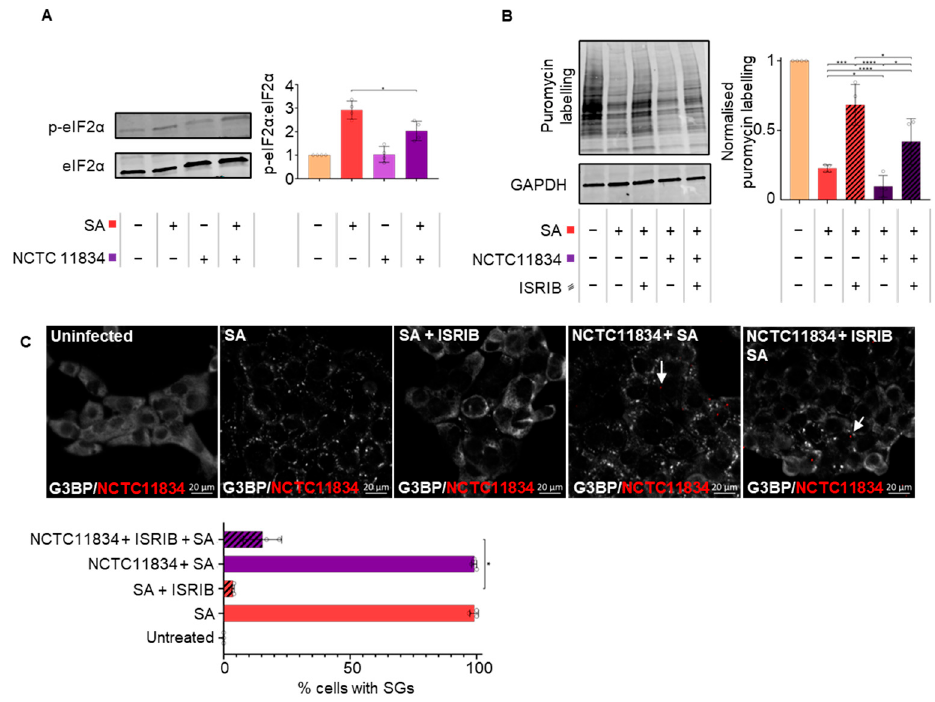
Figure 3. P. gingivalis heightens translational repression independently of eIF2 α in the presence of stress. ( A ) Level of total and phosphorylated eIF2 ɑ (left) and ratio of phosphorylated eIF2 ɑ to total eIF2 ɑ after P. gingivalis (NCTC11834, MOI of 100, t = 2 h) treatment of H357 cells in the presence or absence of sodium arsenite as determined by immunoblotting (right) (mean ± SD, n = 4). ( B ) Relative rate of protein synthesis when H357 cells were treated as above and with ISRIB as determined by puromycin uptake (left) and the concentration relative to GAPDH (right) (mean ± SD, n = 4). ( C ) Stress granule (SG) formation as visualization of G3BP1 (white) and P. gingivalis (red) using confocal microscopy and Z-stacks ( n = 3, 100 cells per biological replicate). **** p ≤ 0.001; ***, p ≤ 0.001; *, p ≤ 0.05 according to Kruskal–Wallis with Conover–Inman post-hoc.